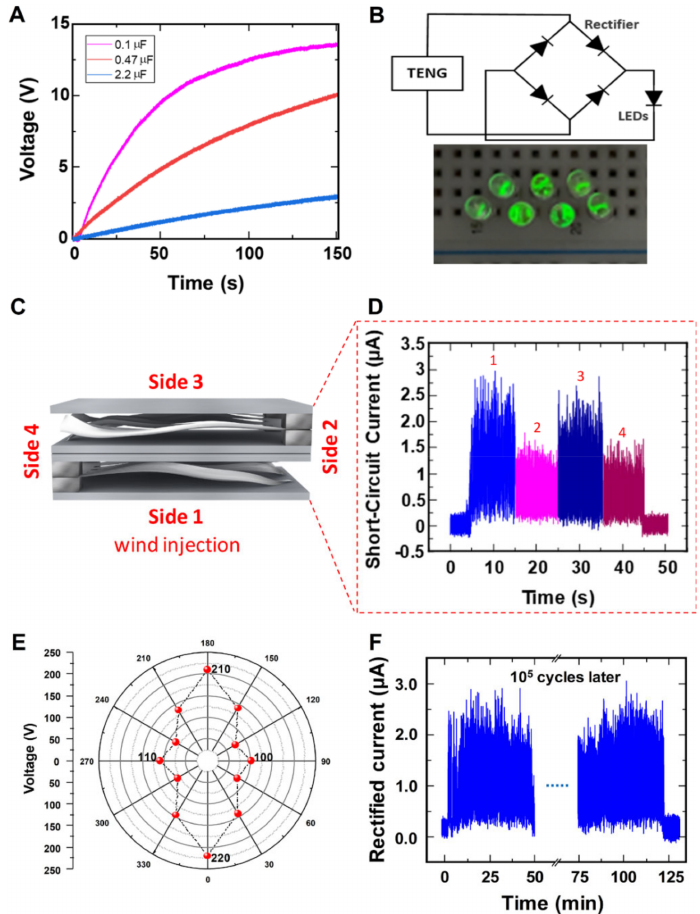
Figure 5. ( A ) Capacitor charging of the wind-TENG with various capacitances. ( B ) Circuit diagram and actual image for powering LEDs. ( C ) Schematic diagram of the integrated device consisting of two TENGs stacking. ( D ) Short-circuit current when the wind is injected into four individual sides of the integrated TENG. ( E ) Polar graph displaying the open-circuit voltage indicating the directionality of wind-TENG. ( F ) Durability test results for the